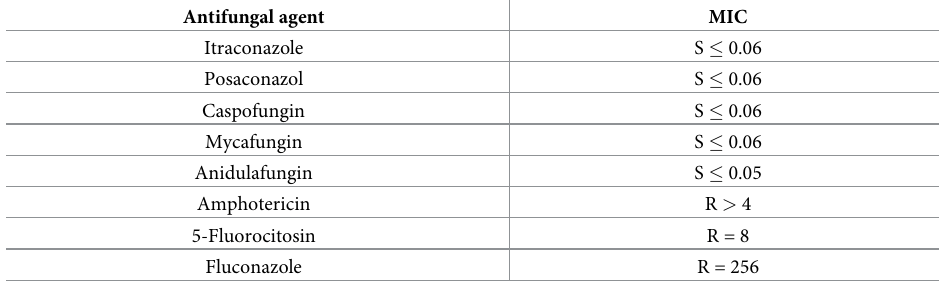
Table 2. MIC of antifungal agents against C . atrobrunneum MRC9 isolate by Sensititre YeastOne